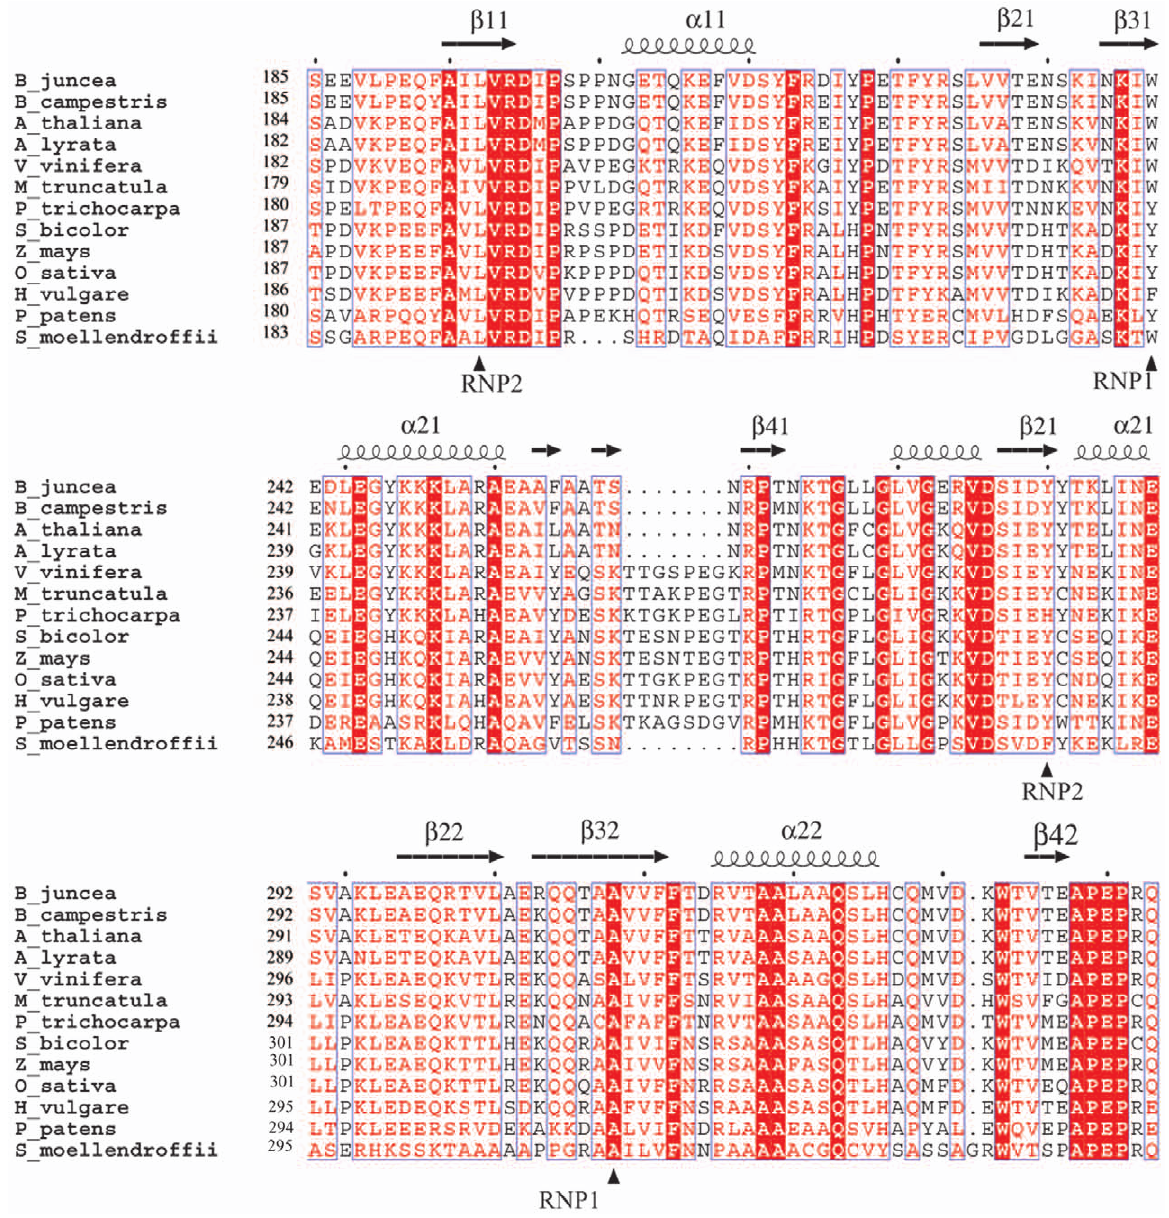
Figure 6. Multiple sequence alignment of the ERD4 globular domain. The alignment was generated by ClustalW. The two RNA-recognition domains are composed of amino acid residues 183–269 (RRM1) and 273–347 (RRM2), respectively. The two ribonucleoprotein motifs of each RRM domain are marked as RNP1 and RNP2. The suggested RNA-interacting residues are marked with filled triangle ( m ). The secondary structure elements of each RRM domain in the theoretical structural model are also shown. The strictly conserved residues in all the plant ERD4 sequences are shaded, while similar residues are boxed. The residues numbering is of the full-length ERD4 proteins.